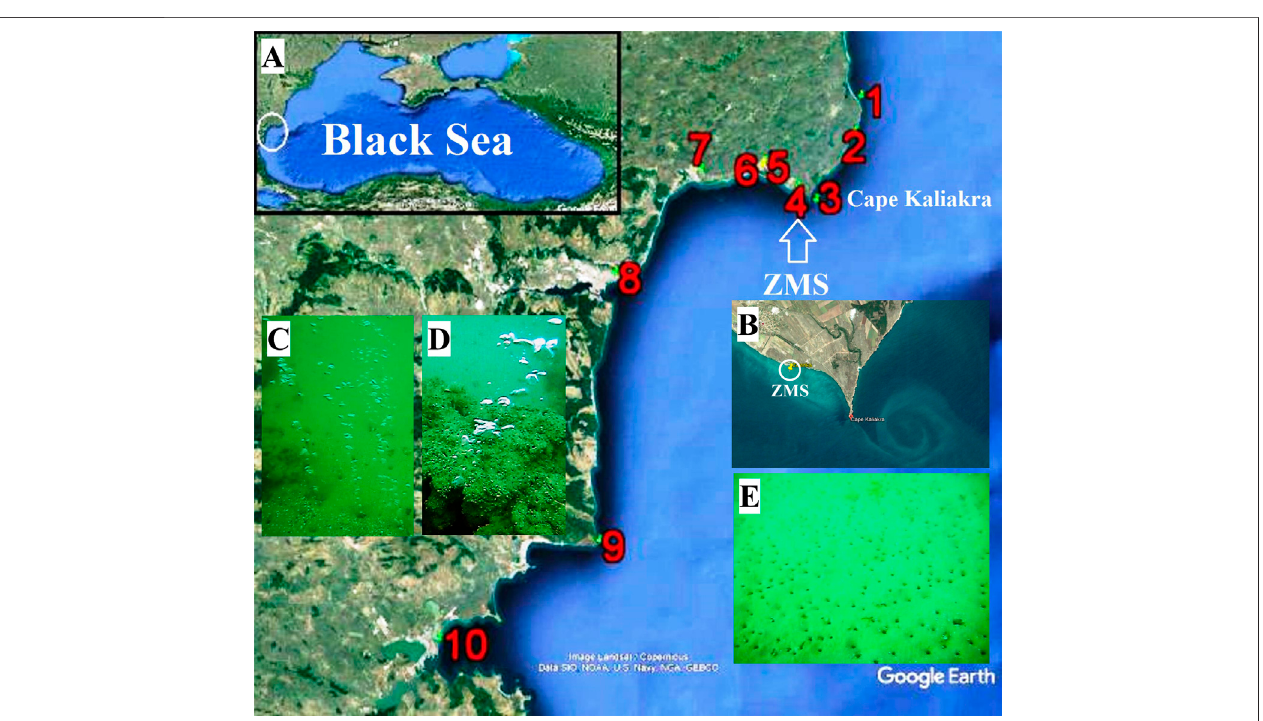
FIGURE 1 | (A) Black Sea (in the upper left corner) and the area of interest (enlarged). Numbers designate geographical locations discussed in the text: 1) cape Shabla, 2) Tyulenovo, 3) cape Kaliakra, 4) Zelenka, 5) cape Chirakman, 6) Town of Kavarna, 7) Town of Balchik, 8) City of Varna, 9) Cape Emine, 10) City of Bourgas (GoogleEarth ™ ) ;(B) capeKaliakraand ZMS(GoogleEarth ™ ); (C) methaneseepsfromthesea fl oorcovered bysand andclayaleurites; (D) ZMSoutcropsofSarmatian limestone; (E) photo of the ZMS sea fl oor with inactive microcraters at water depth ∼ 9 m from Sep. 10, 2009, obtained 36 days after the Md (cid:2) 4.7 earthquake (underwater photos K.